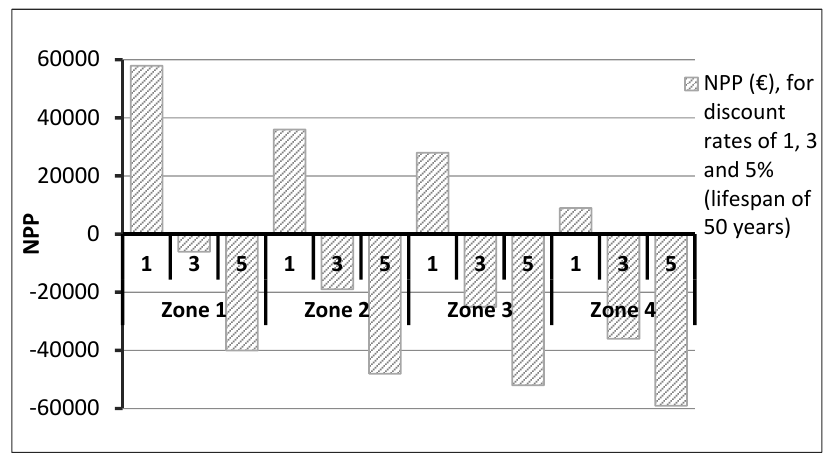
Figure 19. The cost ‐ effectiveness of windows’ energy renovation (changing windows), Figure 19. The cost-effectiveness of windows’ energy renovation (changing windows), corresponding corresponding to the optimum U ‐ values for new windows. to the optimum U-values for new